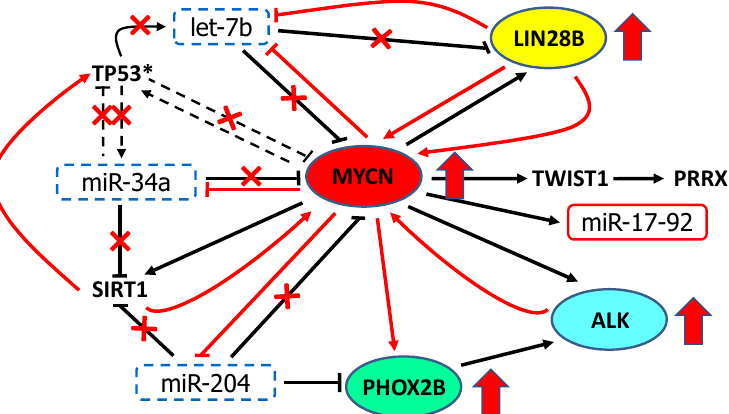
Figure 4. Disruption of physiologic regulation and generation of aberrant transcription activations and feedback loops between miR ‐ 34a, let ‐ 7b, miR ‐ 204, the transcription factors MYCN and PHOX2B and their target genes ALK and LIN28B in neuroblastoma. In NB, underexpression of miR ‐ 34a, let ‐ 7b and miR ‐ 204 (dashed boxes) affects their inhibitory functions (red crosses) and leads to increased levels of TFs and target genes. TF overexpression strongly activates target transcription (bold black arrows) with the consequent disruption of the physiologic regulation and feedback loops (red crosses), generation of enhanced transcription and aberrant feedback loops (red arrows and red in ‐ hibitory lines) with a global upregulation of target genes and increased levels of their encoded pro ‐ teins (large red arrows). De ‐ acetylated TP53 is indicated with an asterisk (TP53*).